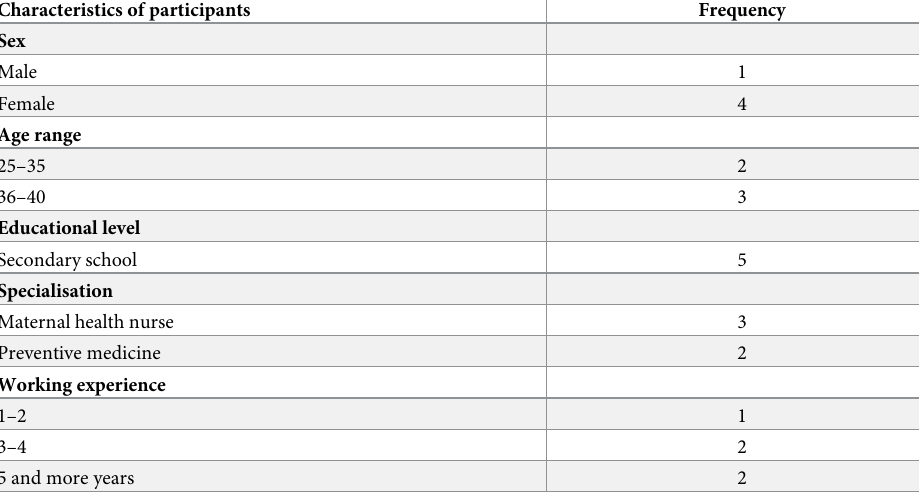
Table 3. Sociodemographic characteristics of healthcare